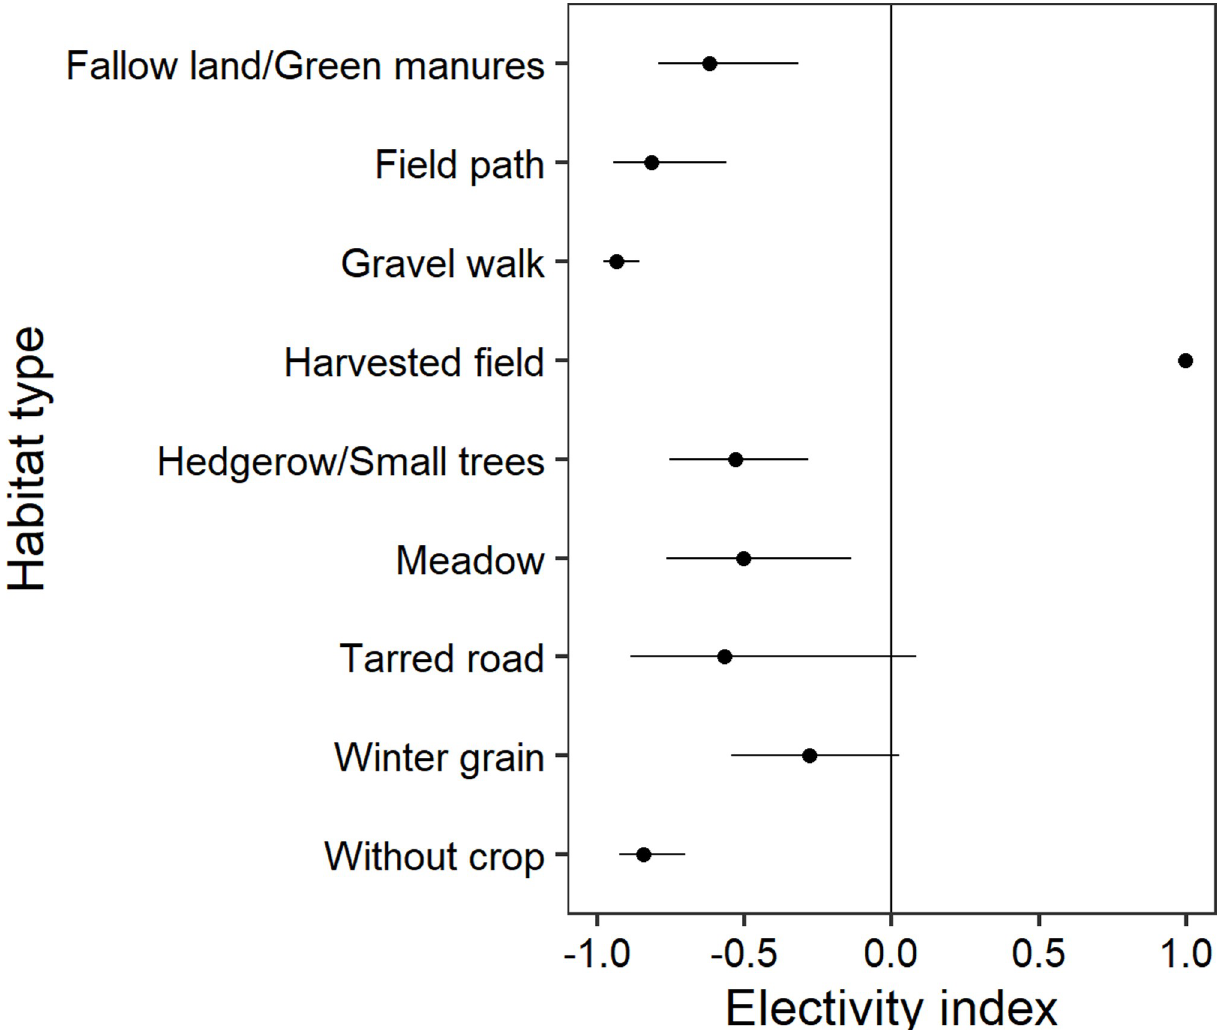
Fig 7. Chesson’s electivity indices for habitat types of the grey partridge during spring 2017. Chesson’s electivity indices and their distributions of 1500 bootstrap resamples (mean and 95% confidence interval) for habitat types of grey partridges in spring based on the fine scale habitat map. Grey partridge individuals (n = 68) were mapped in Vienna district, Austria, in the year 2017. Not significant results cross the vertical line at zero. See text for statistical details.